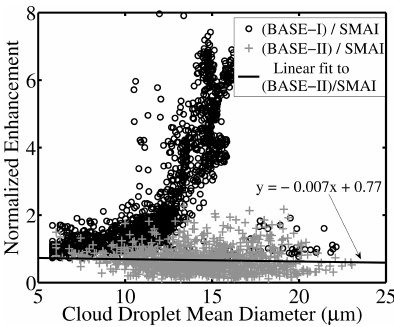
Figure 13. Variation of CN enhancements of BASE-II with temper- ature. At temperatures below − 5 ◦ C, lower enhancements are seen, indicating a reduced shatter-artifact problem with ice particles rela- tive to liquid